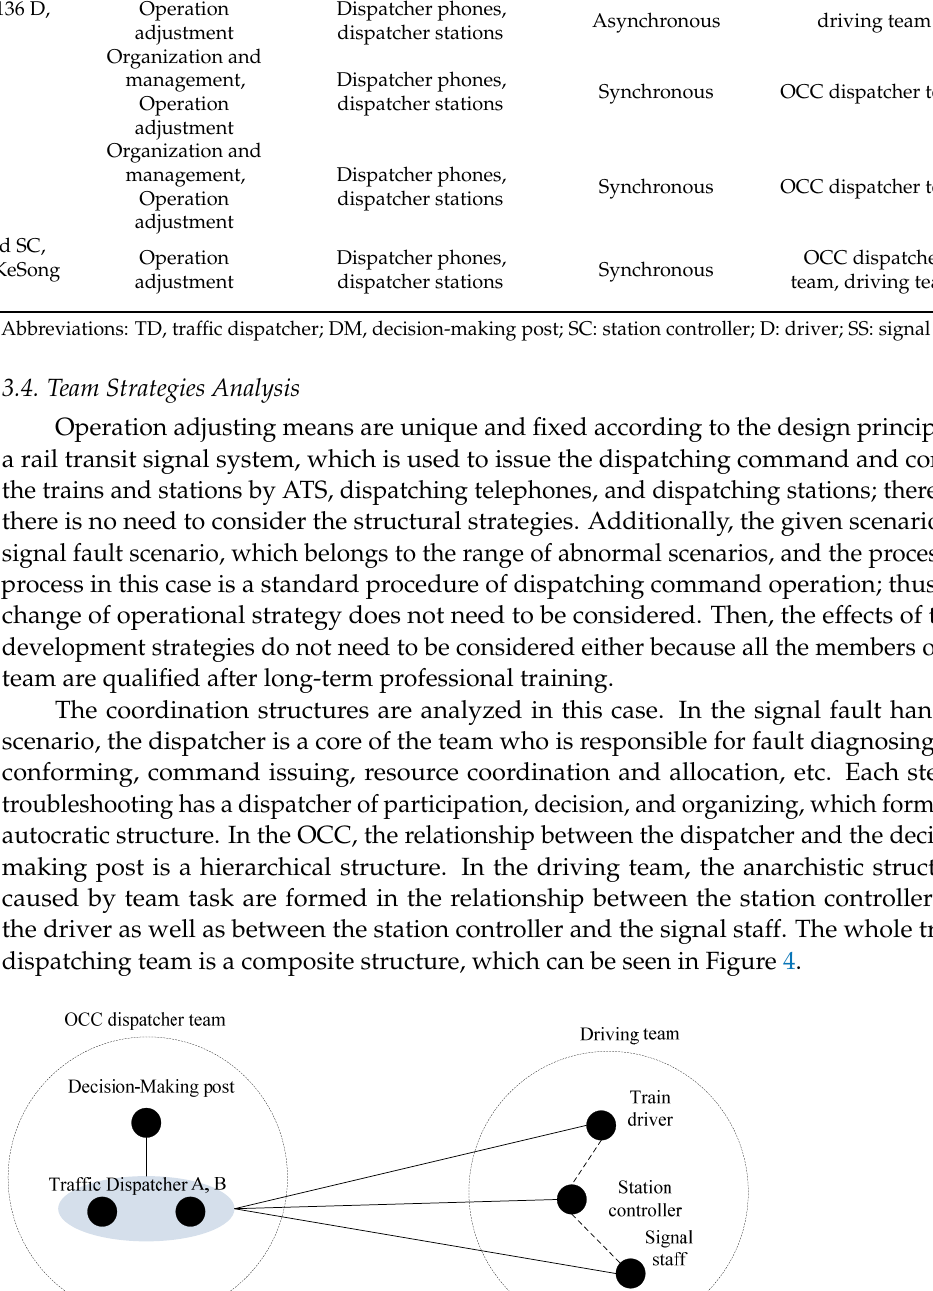
Table 3. Team worker competencies analysis. Team Members